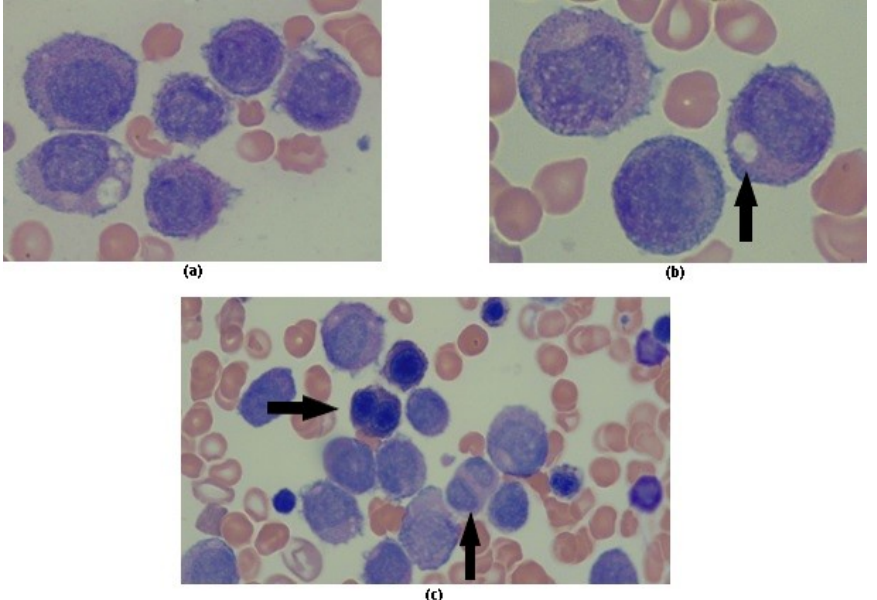
Figure 1. Bone marrow sample. ( a ) Hypergranular leukemic promyelocytes; ( b ) Intracytoplasmic inclusions; ( c ) Dyserythropoiesis and granulocytic dysplasia.